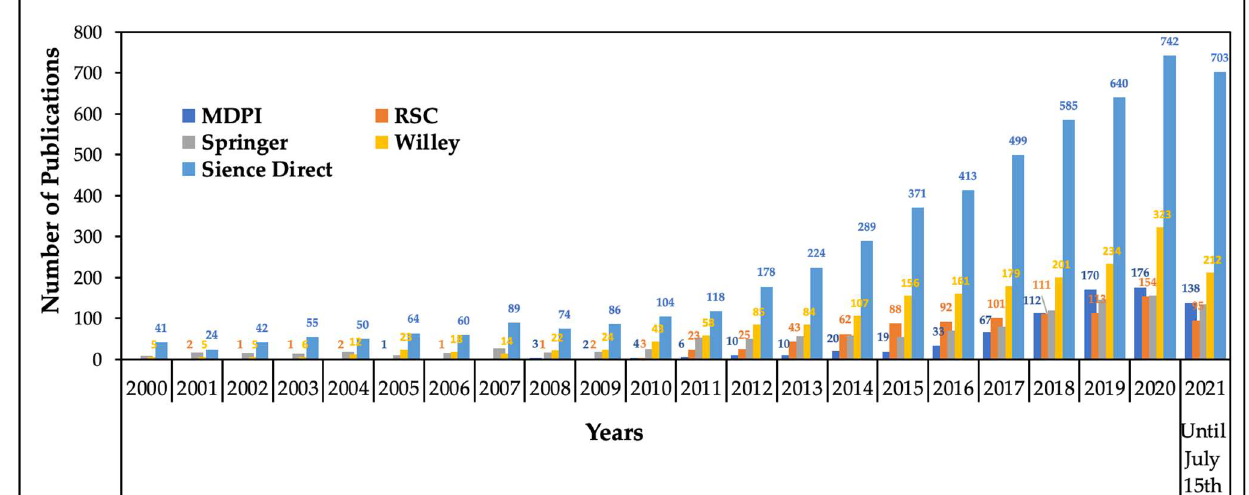
Figure 3. Bar chart of scientific publications published from 2000 until 15 July 2021 found in MDPI journals, Royal Society of Chemistry (RSC), SpringerLink , Wiley Online Library , and Science Direct publications using the search term ““RFB” or “Vanadium RFB” or “flow batteries””.